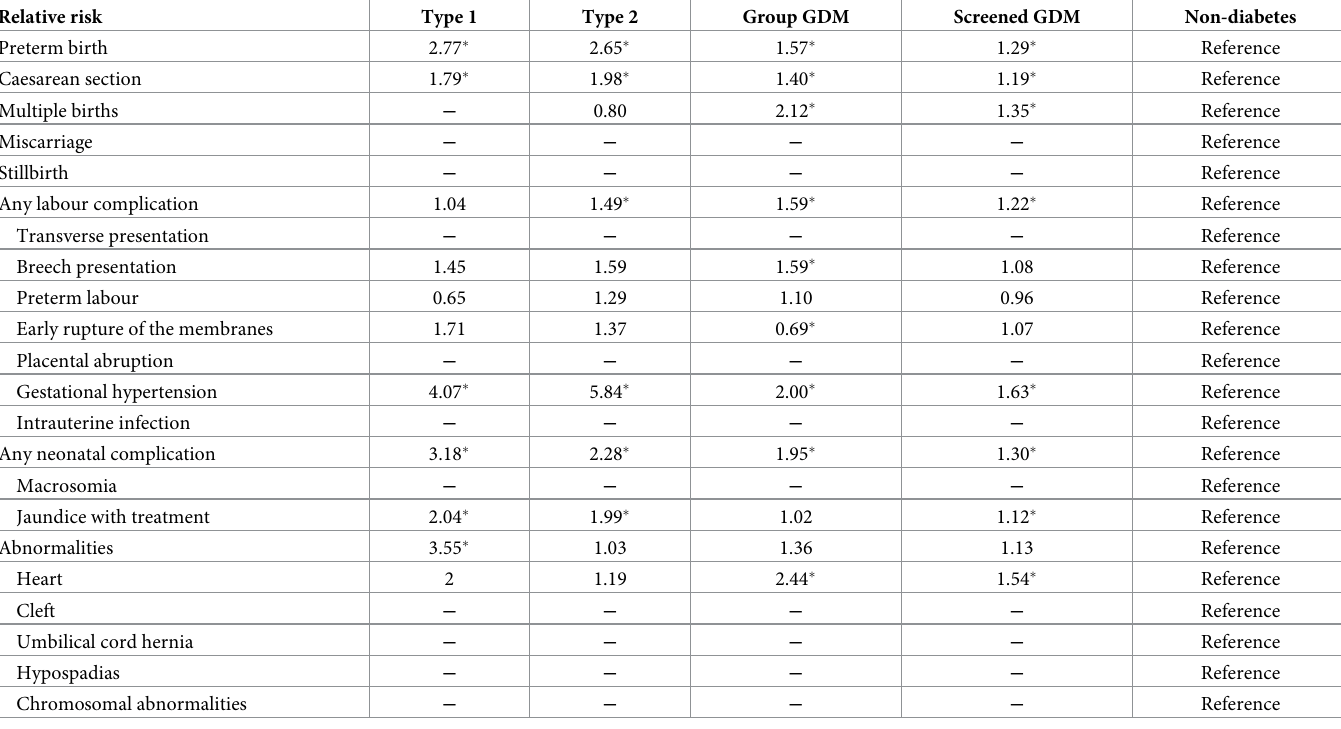
Table 3. Relative risks of perinatal outcomes of mothers with type 1 diabetes, type 2 diabetes, and